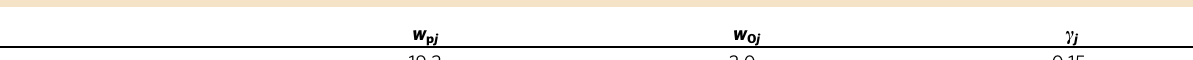
Table 1 | Parameters for the bulk dielectric function of Bi 2 Se 3 .